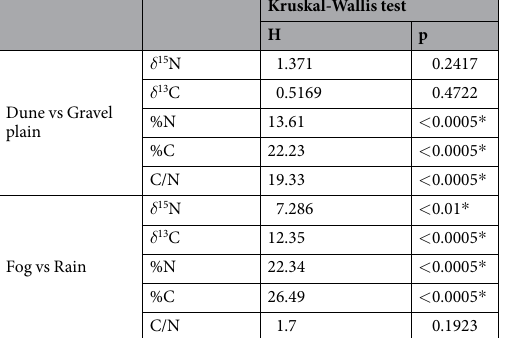
Table 2. Kruskal-Wallis H test results testing if there was a significant difference in the C and N chemistries of samples from different Namib Desert habitat (dune or Gravel plain) or precipitation regime zones (fog vs rain). H: Kruskal-Wallis test H(chi 2 ) statistic. * Significantly different (p < 0.05).